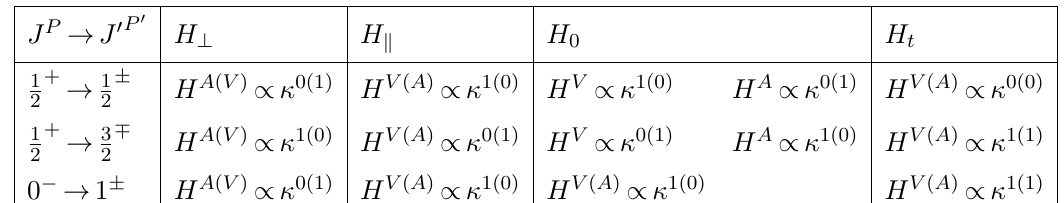
0 HAs. The table is an extension of table 1 in [2] is not of definite parity and this is why both 0 ) HAs follows the same pattern as 5